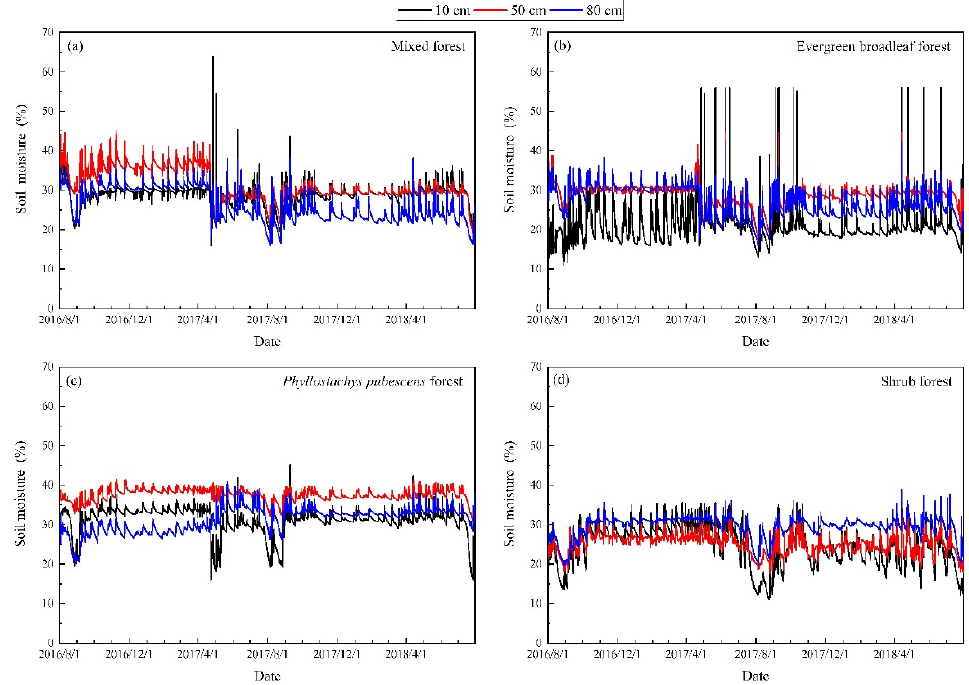
Figure 4. Changes of soil moisture (volumetric moisture) at different soil depths in ( a ) mixed forest, ( b ) evergreen broadleaf forest, ( c ) Phyllostachys pubescens forest and ( d ) shrub forest.